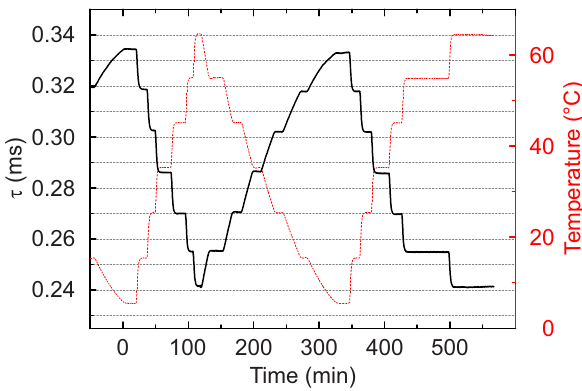
Figure 9. Response of the luminescence decay time of the fiber optic temperature microsensor (black trace). The temperature in the calibration chamber is measured by PT-100 resistance thermometer (red trace).